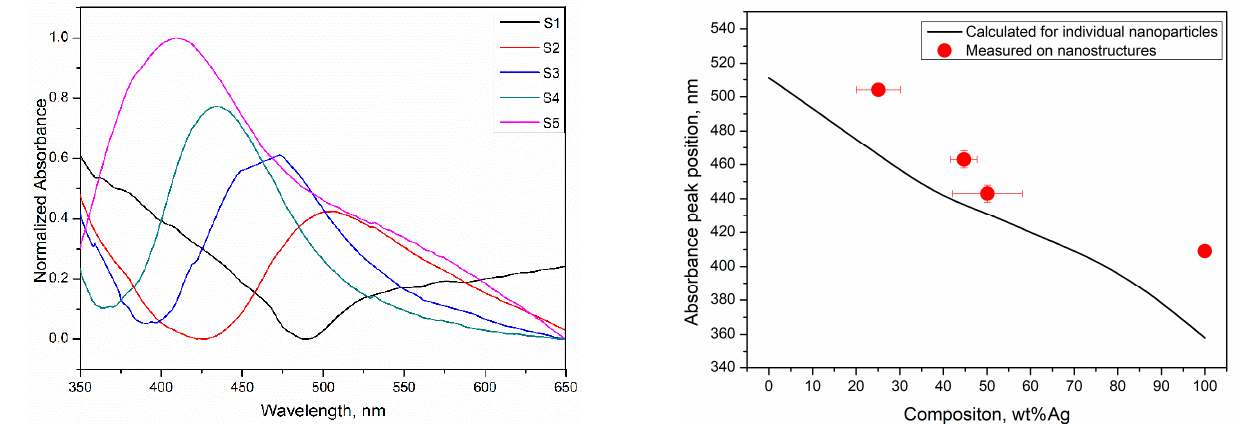
Figure 4. Normalized absorbance spectra of the samples S1–S5 ( left ), variation of the absorbance peak position measured on the samples and calculated for individual nanoparticles as a function of composition ( right ).